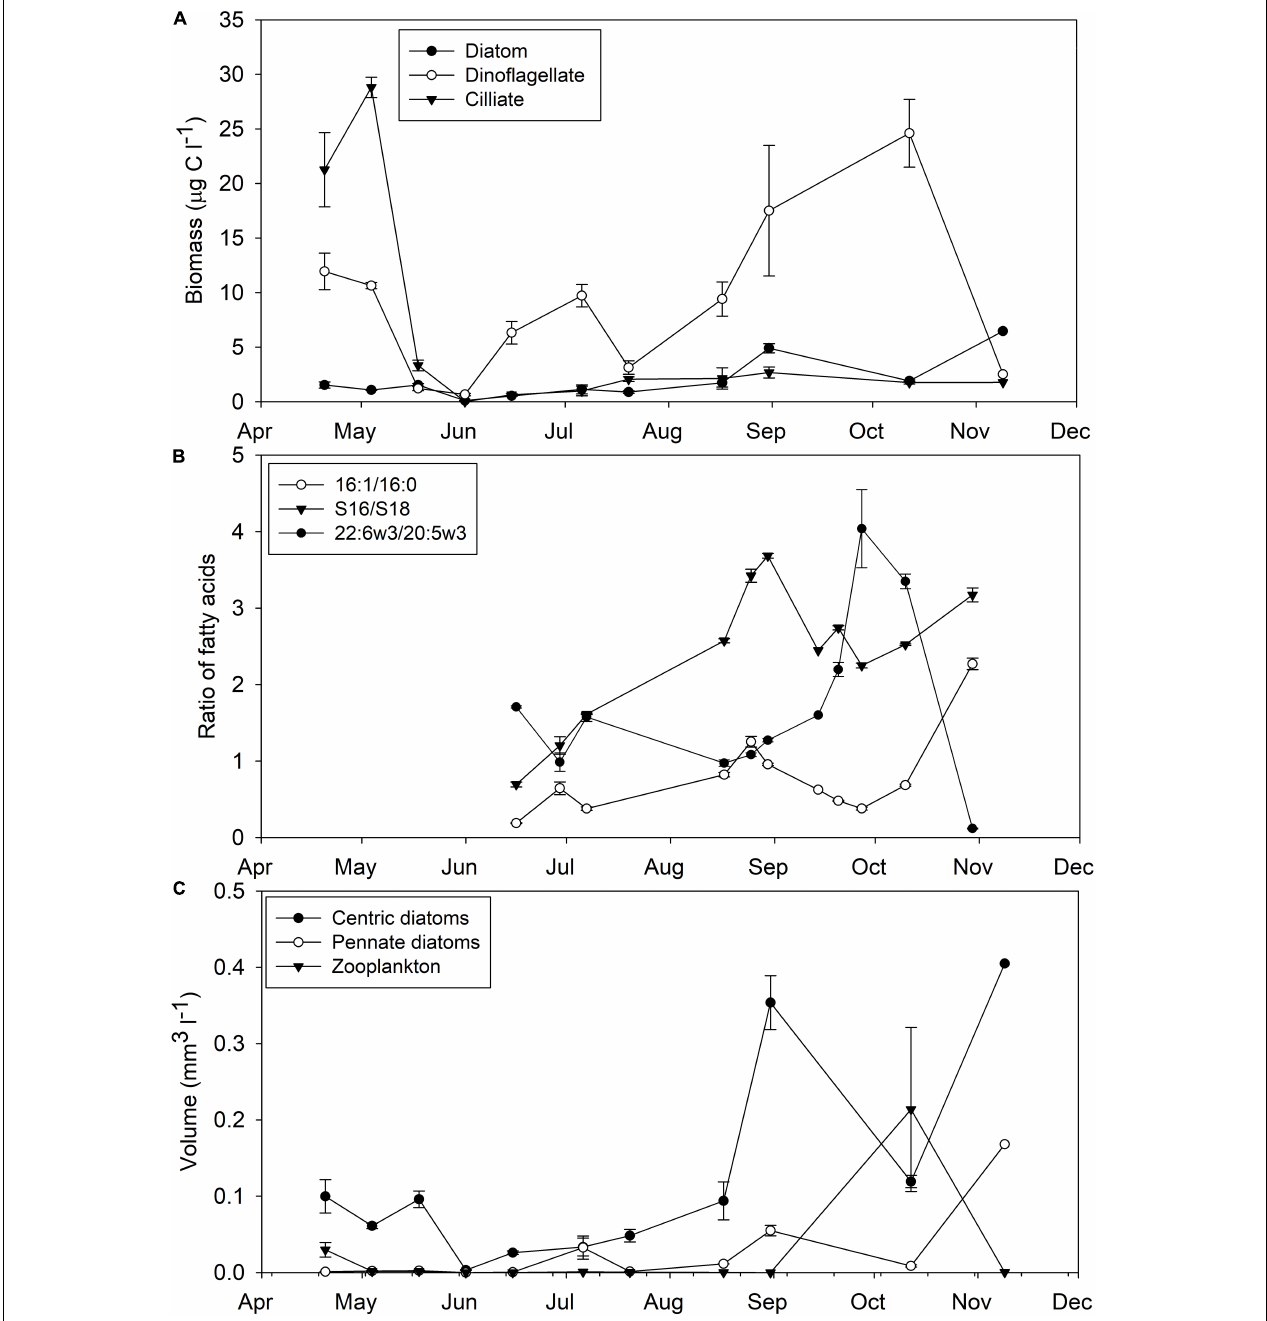
FIGURE 2 | Selected components of the plankton community composition in Saco Bay, ME, United States, throughout 2016. (A) Biomass ( µ g C l − 1 ) of diatoms, dinoflagellates, and ciliates. (B) Diatom fatty acid indices (16:1-to-16:0 and (cid:54) 16-to- (cid:54) 18) and a dinoflagellate index (22:6 ω 3-to-20:5 ω 3). (C) Volume (mm 3 l − 1 ) of centric diatoms, pennate diatoms, and zooplankton. Error bars represent ± 1 standard